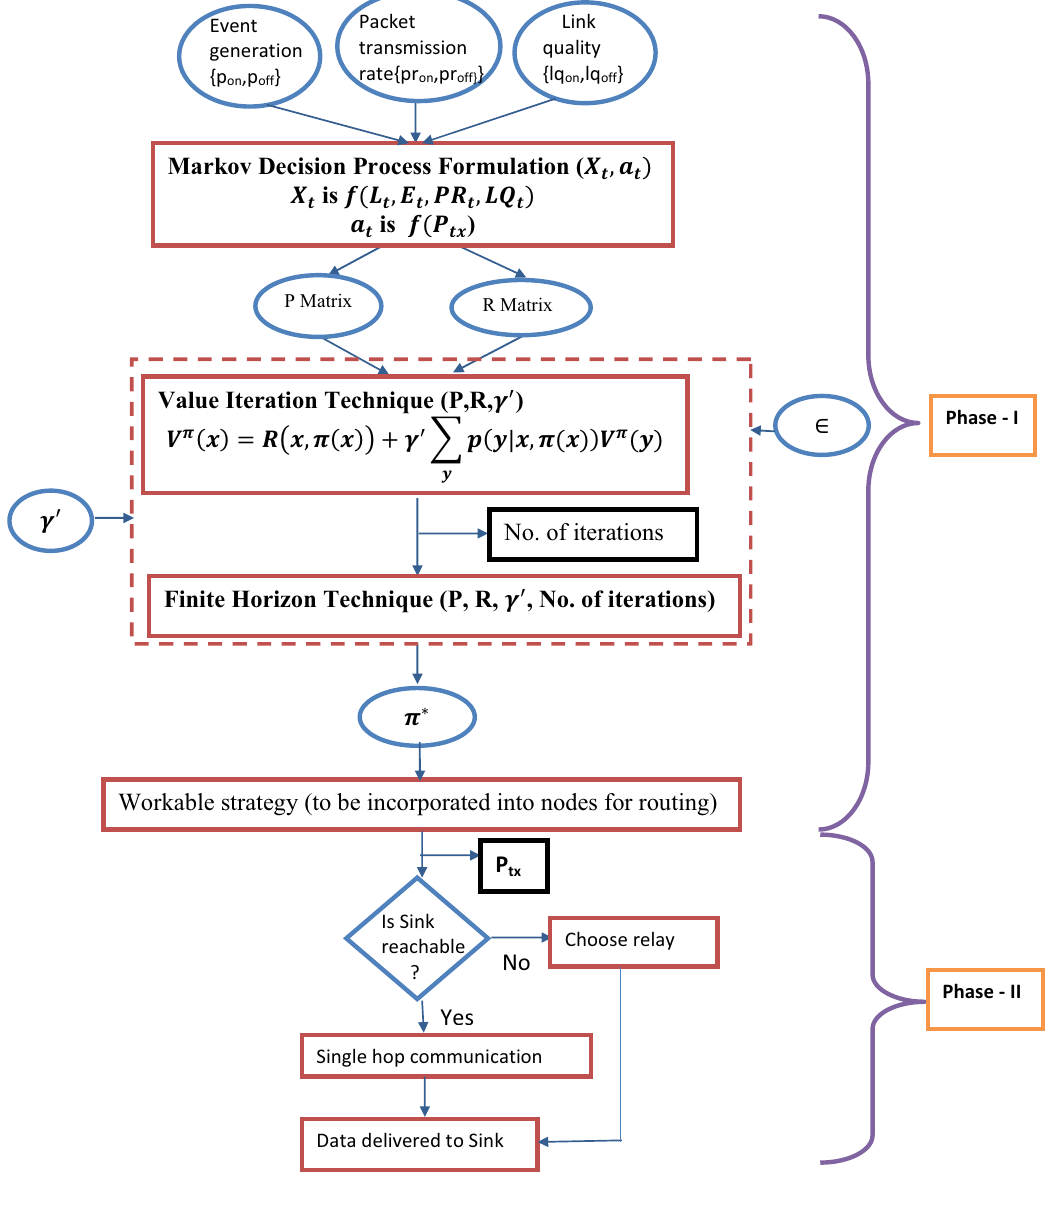
Figure 4. Work flow of MDP formulation of our